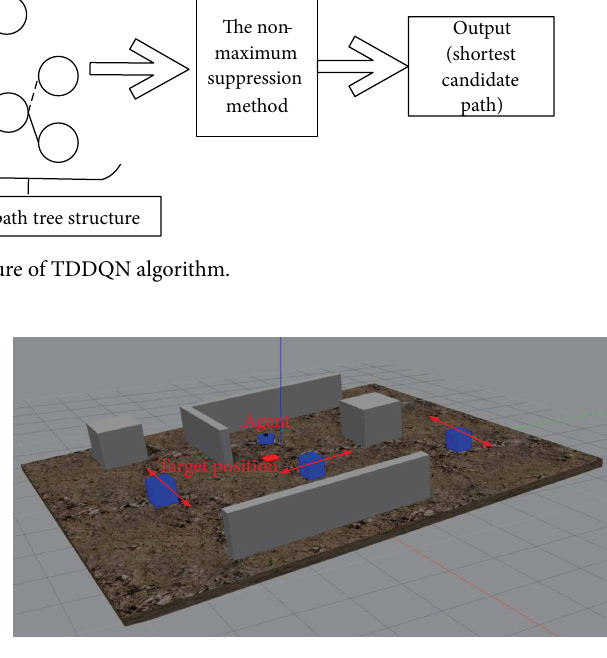
Figure 6: Gazebo physical simulation environment. The range and direction of movement are indicated by red